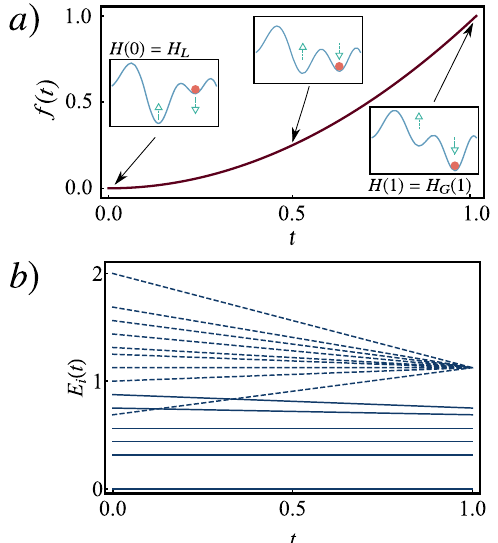
Fig. 2 Adaptive cost function. a Schematic representation of the function f ( t ) and the cost landscape of C ( t , θ ) versus t . We choose f ( t ) as a slowly growing function with t . When the optimization starts at t = 0, the cost function does not exhibit a barren plateau as the Hamiltonian is local H (0) = H L . As t increases H ( t ) becomes a linear combination of H L and a global Hamiltonian H G ( t ) which is adaptively updated using information gained from measurements on V ( θ ) ρ V † ( θ ). As shown in the insets, this procedure allows for local minima to become global minima. Finally, when the algorithm ends at t = 1 the Hamiltonian is global H ( t ) = H G ( t ). b Schematic repre- sentation of the eigenenergies of H ( t ) versus t . For small t the Hamiltonian is local and hence its spectrum contains non- degenerancies that reduce the space of solutions. At t = 1, H ( t ) becomes a global Hamiltonian and the spectrum has m non- degenerate levels and a (2 n − m )-degenerate